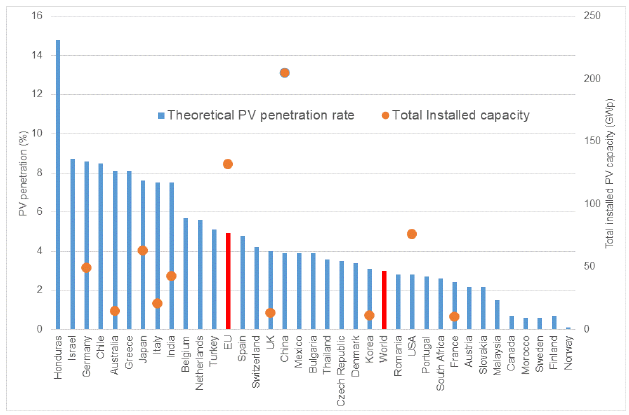
Figure 1. Theoretical penetration rate (annual basis) and cumulated PV capacity